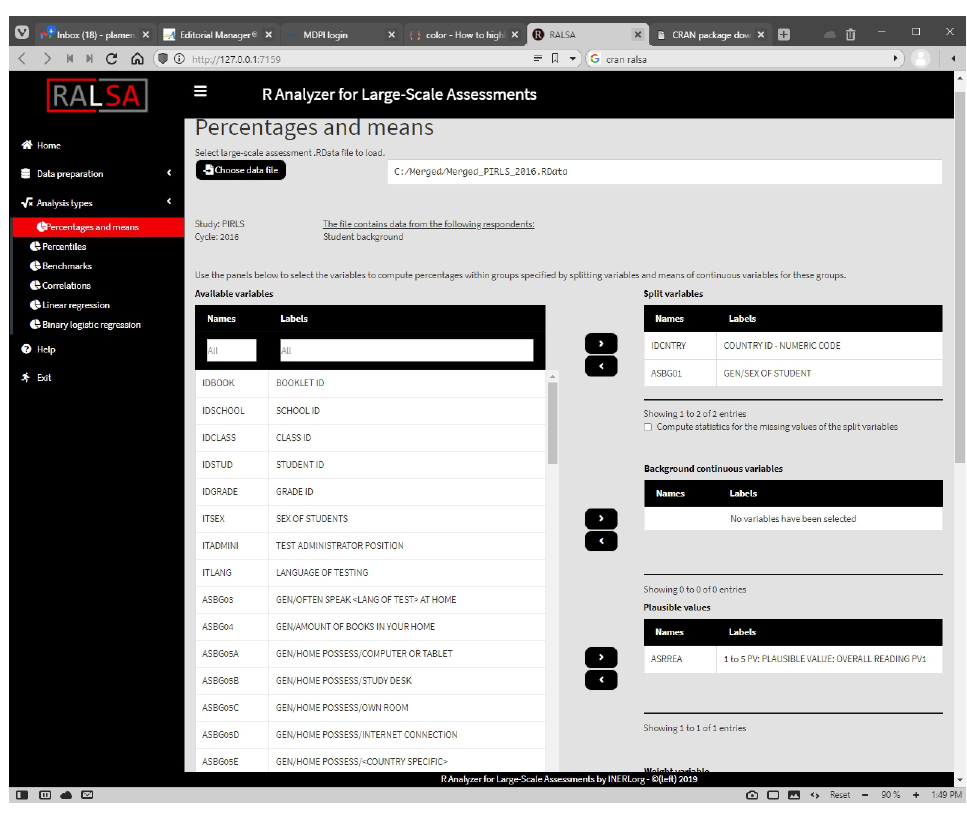
Figure 3. Sample analysis with RALSA using the